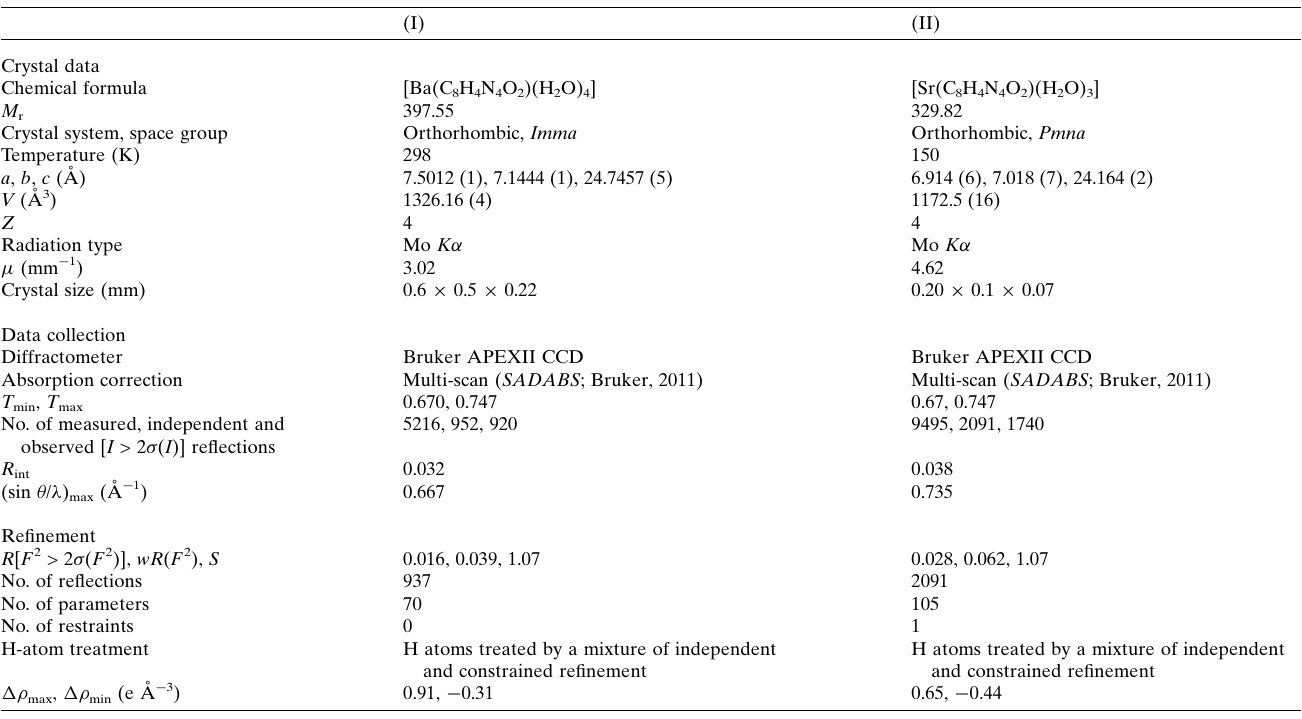
Crystal data Chemical